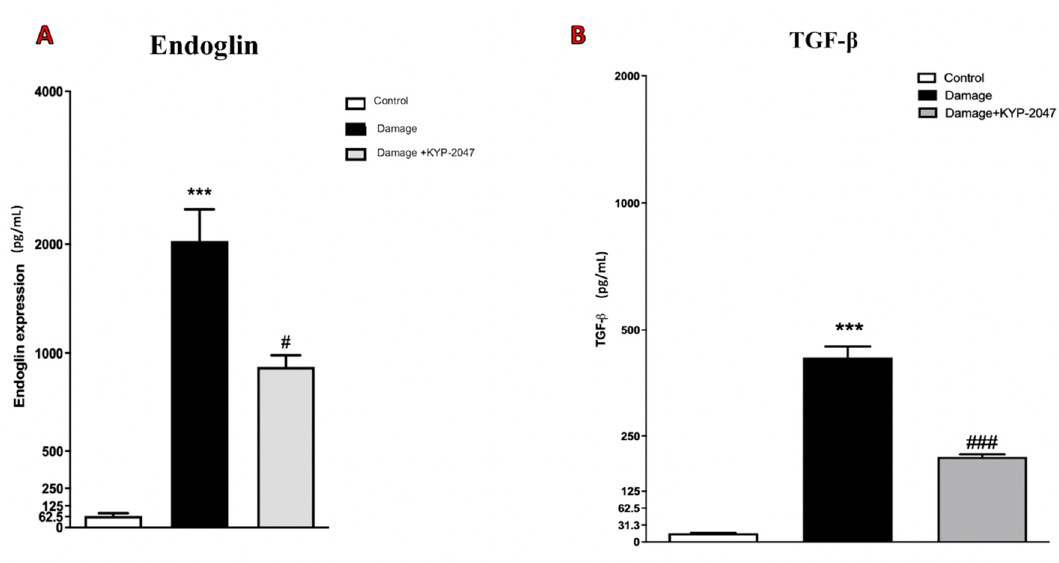
Figure 9. KYP-2047 treatment on TGF- β 1 and Endoglin levels on saphene vein from tissue block culture study. The content of endoglin and TGF- β 1 were evaluated by ELISA kits, revealing an increase in damaged group compared to control ( A , B ), while KYP-2047 treatment notably reduced this increase ( A , B ). Data represent the means of at least three independent experiments. One way ANOVA followed by Bonferroni post-hoc. *** p < 0.001 versus Sham; # p < 0.05 and ### p < 0.001 versus